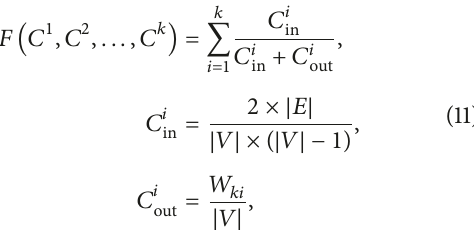
cuckoo 𝑖 , and | nest 𝑗 | is the number of vertices in nest 𝑗 . In order to keep the diversity of population, the roulette wheel selec- tion was used. For a cuckoo 𝑖 , if closeness ( cuckoo 𝑖 , nest 𝑗 ) > 0 , the nest 𝑗 is selected to construct the roulette